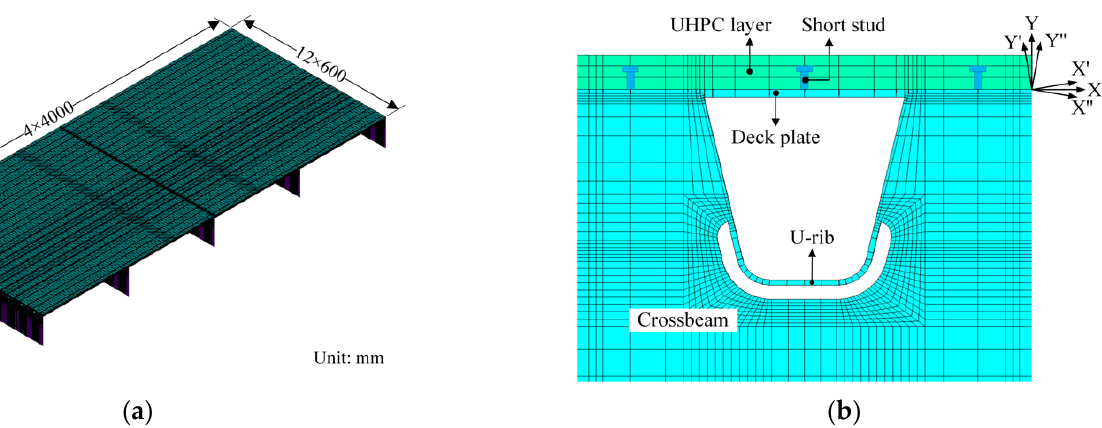
Figure 3. Local FEM of LWCD: (a) Full view of FEM; (b) Detail view of interest.